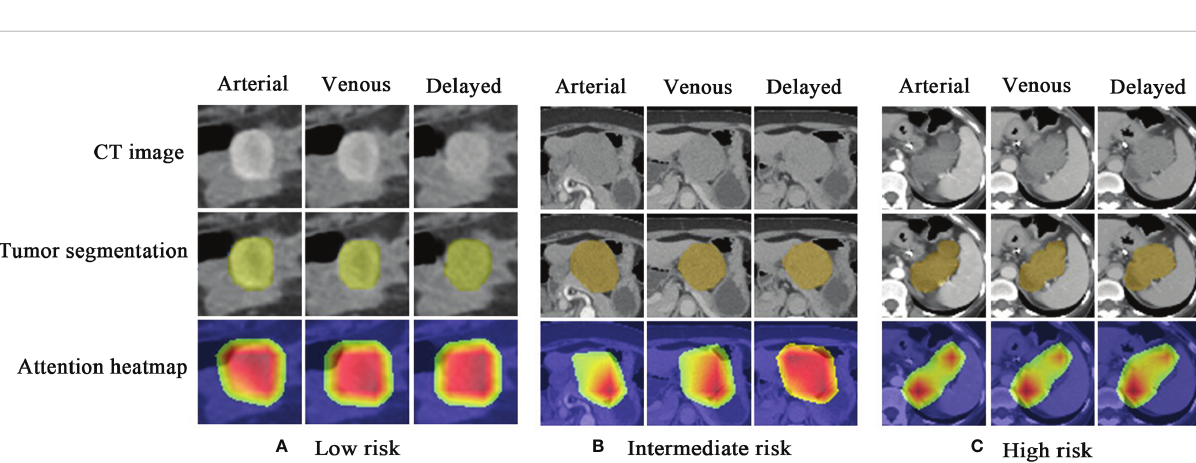
FIGURE 5 | Confusion matrix of the DLM for risk strati fi cation of gastrointestinal stromal tumors. (A) Confusion matrix for the testing cohort. (B) Confusion matrix for the independent external validation cohort. DLM, deep learning model.